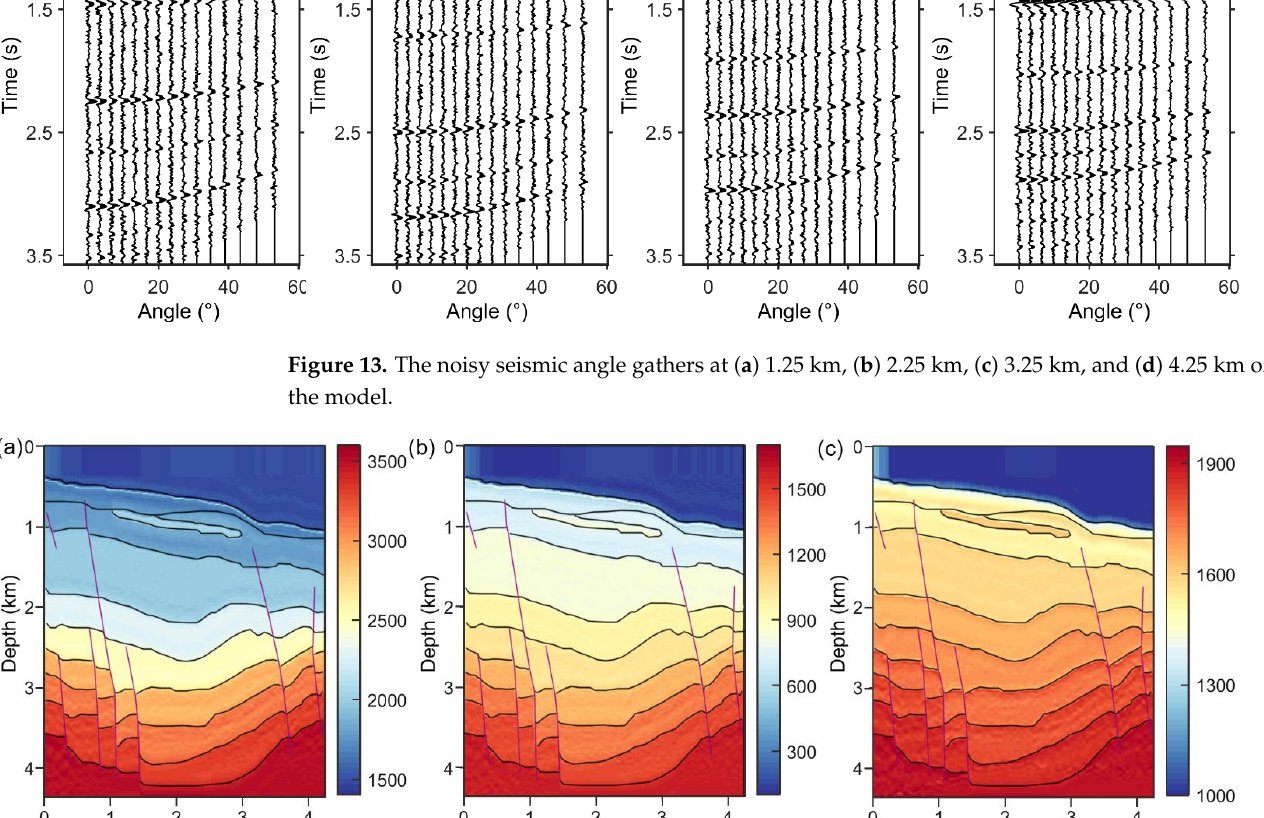
Figure 15. Comparison between the true model at 2.25 km and the inverted model from the noisy data using the wave-equation-based inversion method: ( a ) P-wave velocity, ( b ) S-wave velocity, and ( c ) density. The black arrow indicates the location of the gas hydrate reservoir. Figure 16. ( a ) Synthetic seismic angle gathers at 2.25 km after the wave-equation-based inversion method, ( b ) difference between the real seismic gather in Figure 10b and synthetic seismic gather in ( a ).